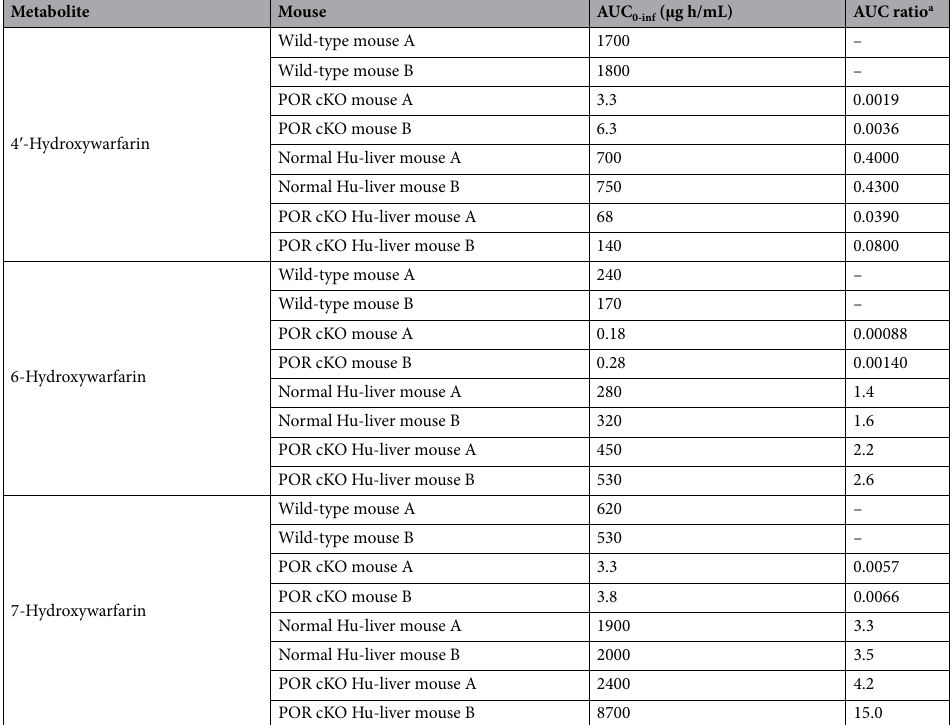
Table 2. AUC 0-inf of metabolites after single intravenous administration of S -warfarin at 4.0 mg/kg to wild-type, POR cKO, Normal Hu-liver, and POR cKO Hu-liver mice. a Ratios of AUC 0-inf in POR cKO mice, humanized liver TK-NOG mice (Normal Hu-liver), and POR cKO humanized liver (POR cKO Hu-liver) mice compared to those in wild-type mice (mean value of two animals). Normal Hu-liver mouse A and B (human Albumin: 6.5 and 6.6 mg/mL, Cholinesterase activity 255 and 425 U/L, Replacement Index 72.5% and > 95% estimated with Cholinesterase activity), POR cKO Hu-liver mouse A and B (human Albumin: 7.6 and 8.3 mg/mL, Cholinesterase activity 265 and 470 U/L, Replacement Index 75.1% and > 95% estimated with Cholinesterase